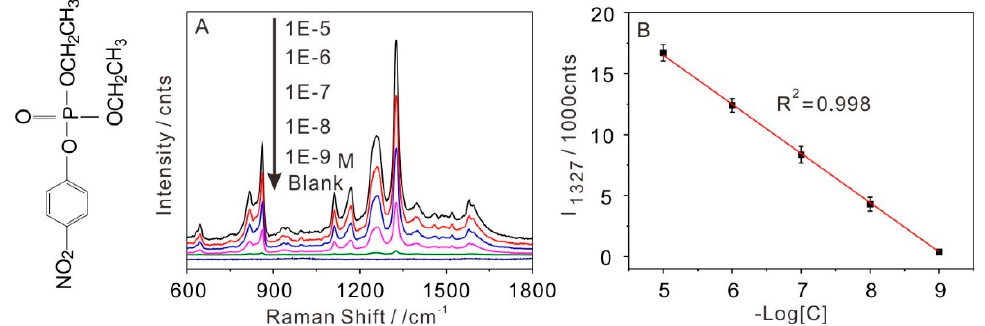
Figure 3. ( A ) SERS spectra obtained from different concentrations of paraoxon using self-assembly Au NPs arrays and blank substrate, the left of Figure 3A is the molecular structure of paraoxon; ( B ) the linear correlation of Raman intensity at 1327 cm − 1 with the logarithm of paraoxon concentration.